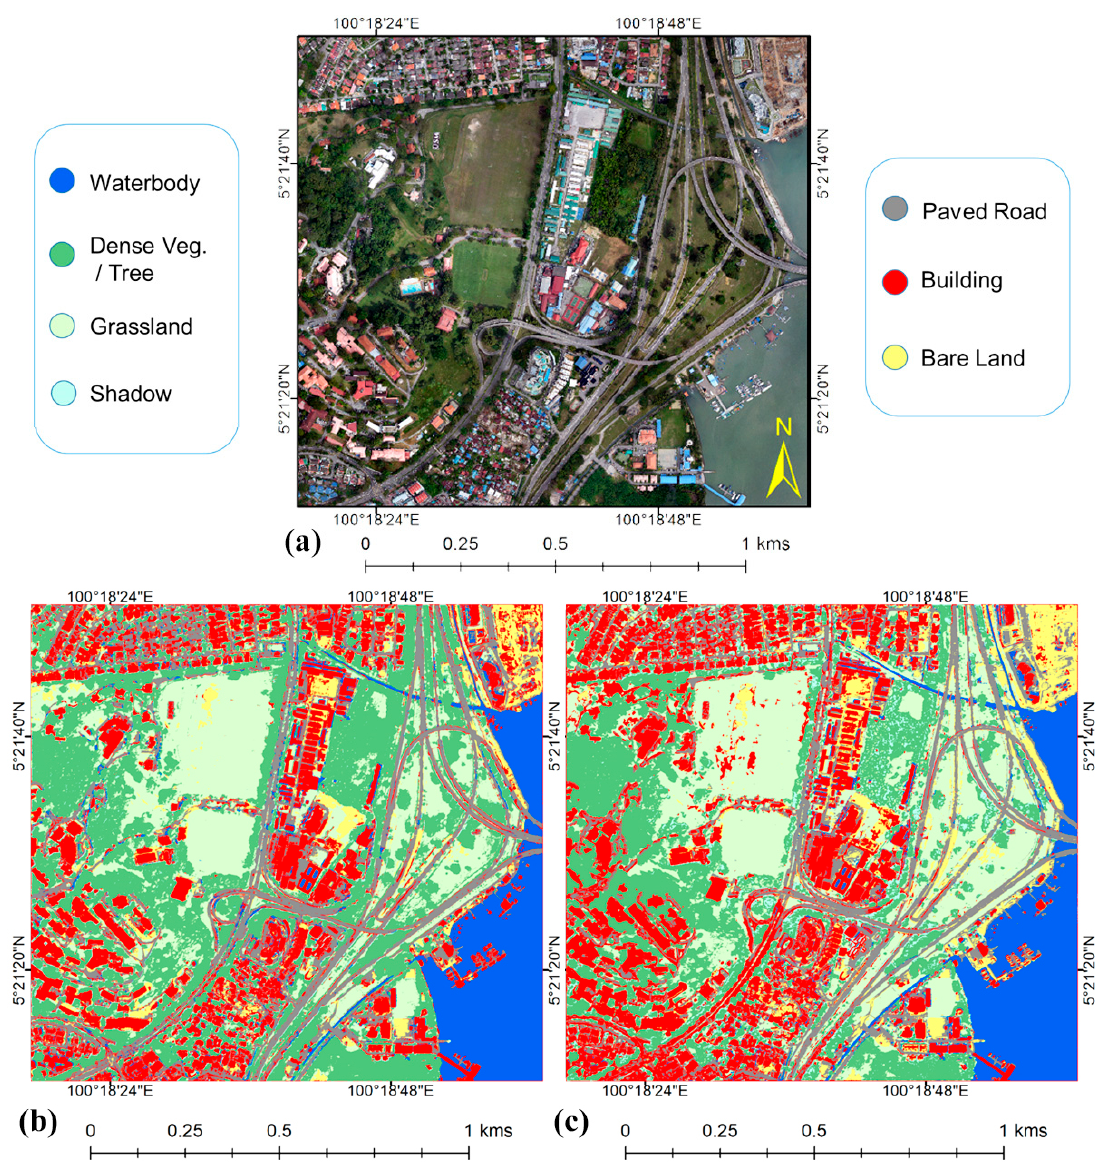
Figure 3. Classification map produced by the CNN based on the two datasets: ( a ) GT, ( b ) RGB only dataset and ( c ) RGB + DSM dataset.